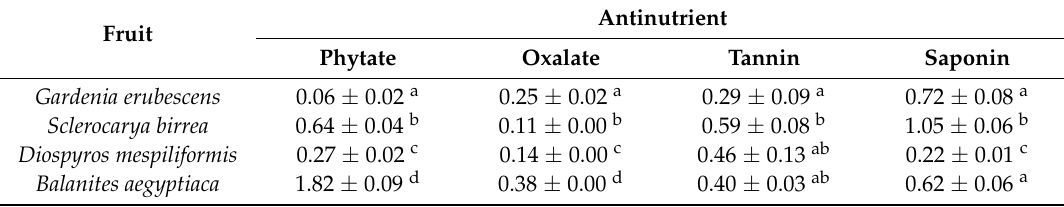
Table 5. Antinutrient content (mg/g) of four underutilized forest